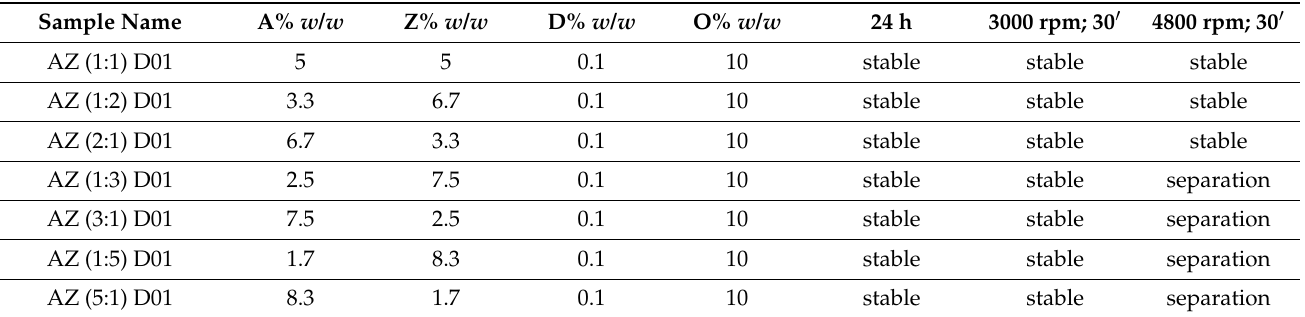
Table 5. Stability test results of emulsions formulated with 10% w / w of oil phase O, 0.1% w / w